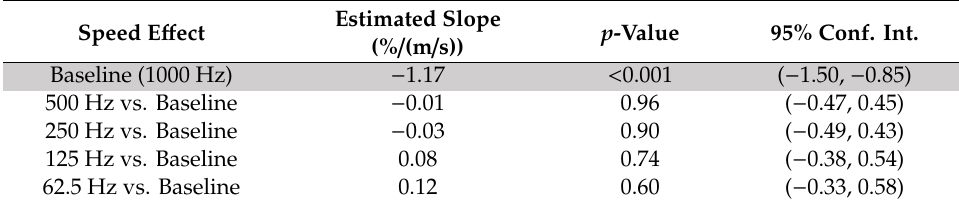
Table A4. E ff ect of speed on the cumulative distance versus sampling frequency for Method 2 (decimation). First (shaded) row reports the estimated slope of the cumulative distance traveled versus mean speed using the baseline sensor (1000 Hz). Remaining (unshaded) rows report the estimated di ff erences in this slope for IMUs with the indicated sampling frequency compared to the baseline IMU (i.e., the increased error sensitivity to speed following the indicated reductions in sampling frequency relative to the baseline sampling